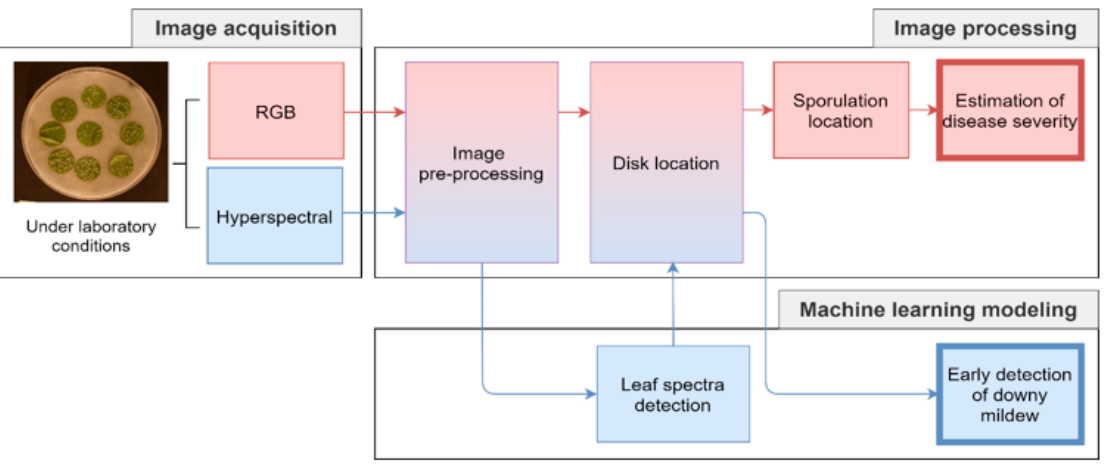
Figure 1. Flowchart of the use of novel sensing technologies and artificial intelligence for assessing downy mildew in grapevine leaves: RGB images taken under laboratory conditions (red boxes) were used for downy mildew severity estimation, and hyperspectral images (blue boxes) were used to detect this disease early.